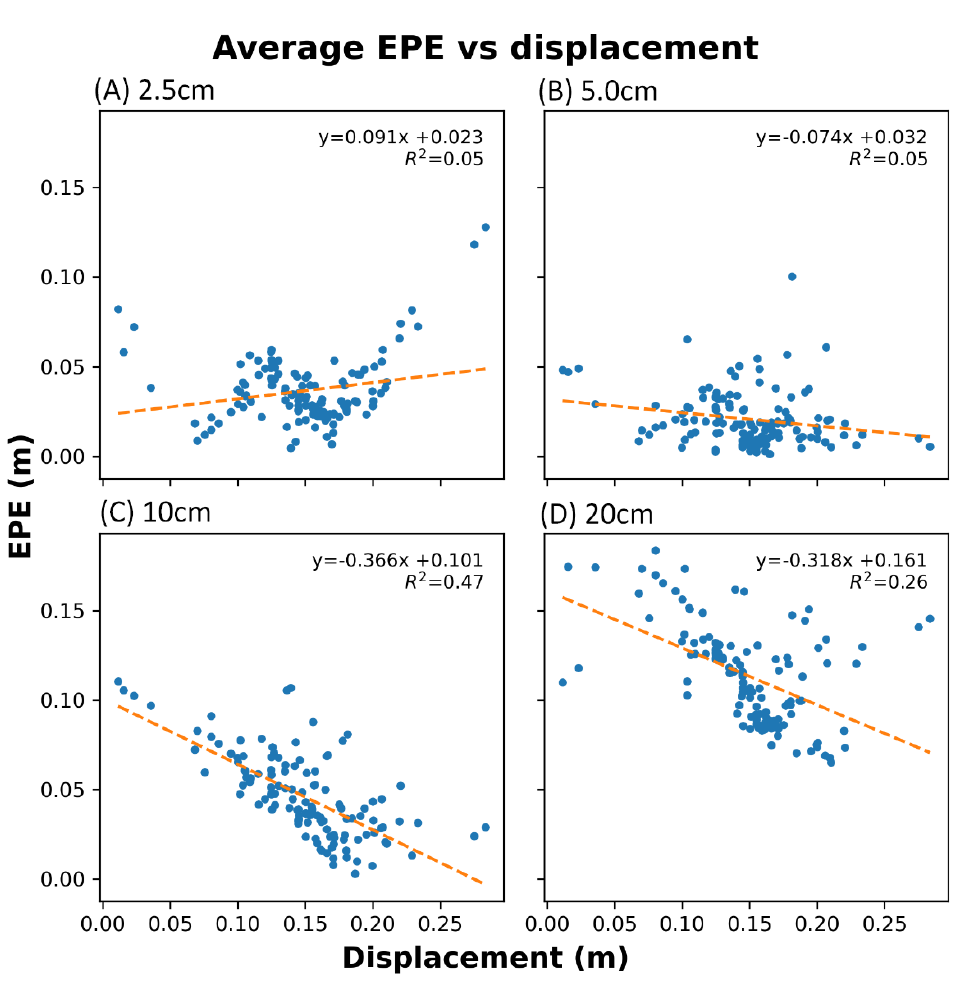
Figure 5. EPE vs. magnitude of displacement for four different input model cell sizes evaluated against the ground truth dataset.